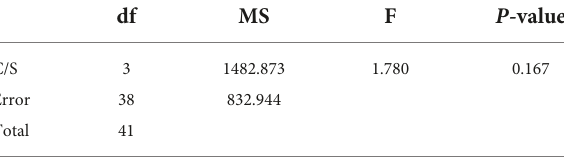
TABLE 5 Result of the analysis of variance for the effect of treatment with different ratios of cross- and self-pollen on seed numbers per mature fruit in the pollen-enough